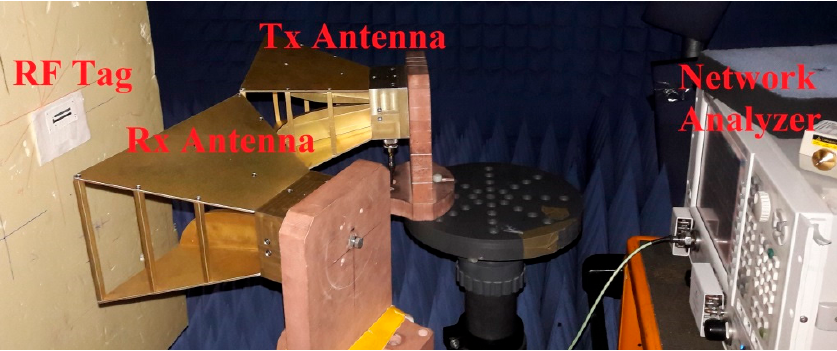
Figure 11. Bistatic radar setup used for RCS measurements of the Tag.